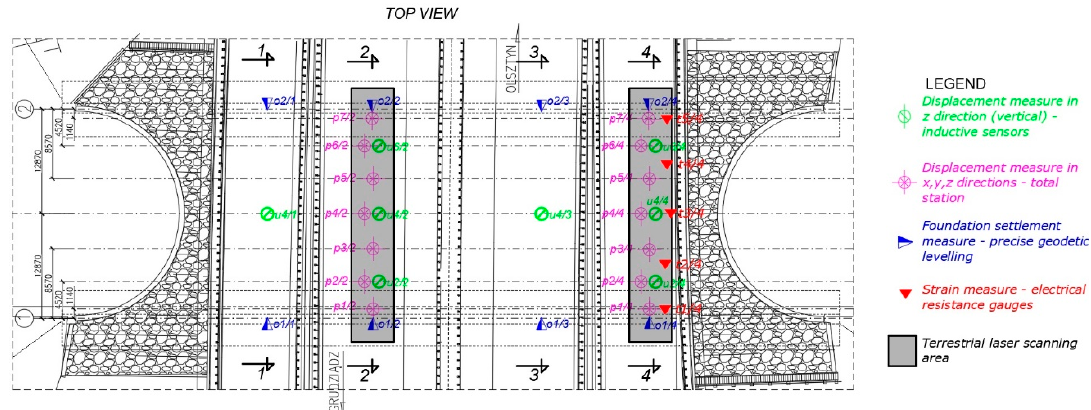
Figure 5. Location of the network of sensor used to collect the data during the static tests. Top view of the bridge.